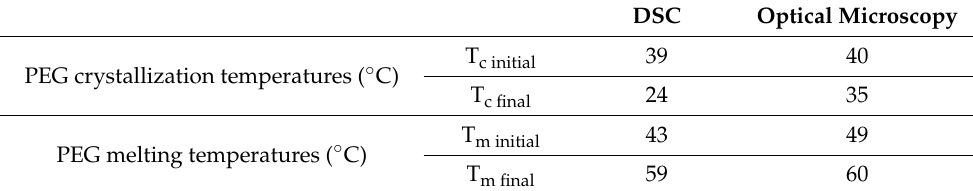
Table 2. Comparison of melting and crystallization temperatures of PEG homopolymer determined by optical microscopy and